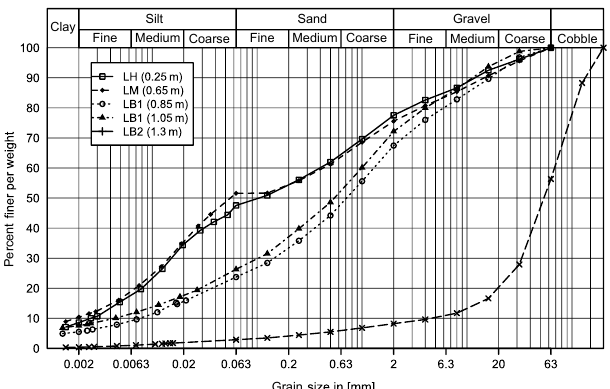
Figure 2. Grain size distribution of samples from the trench at dif- ferent